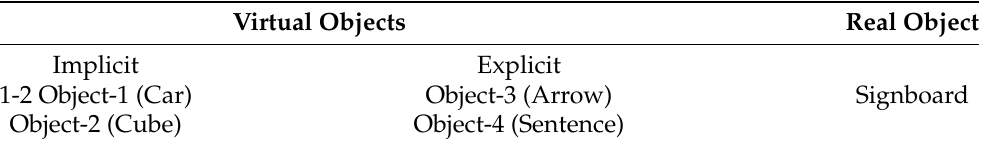
Table 3. The classified features of each